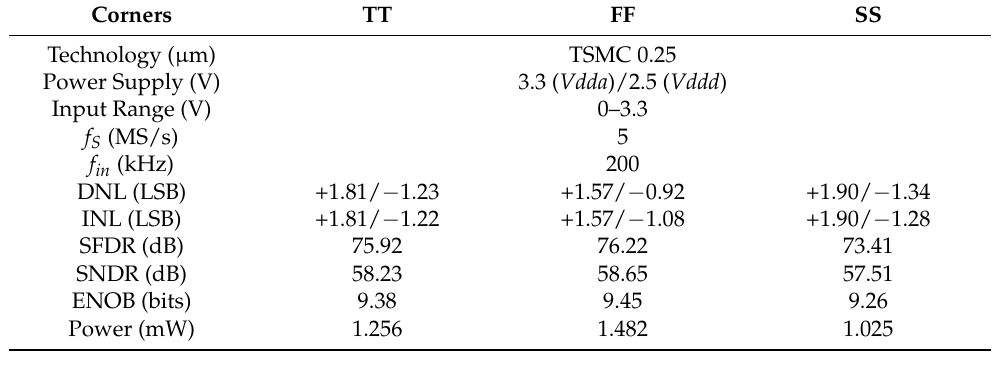
Figure 21. Post-layout simulated PSD of the proposed PLL-SAR ADC.